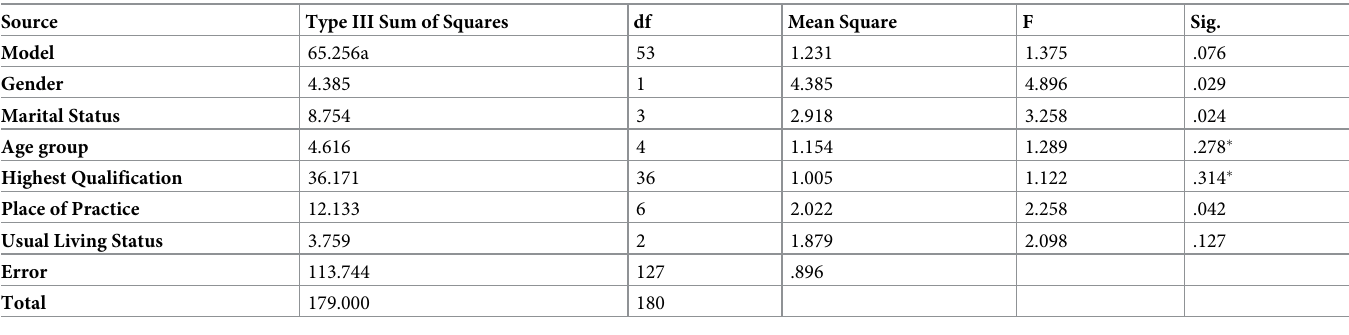
Table 4. Illustrates the model fit of the regression between work-life balance and the demographic variables.